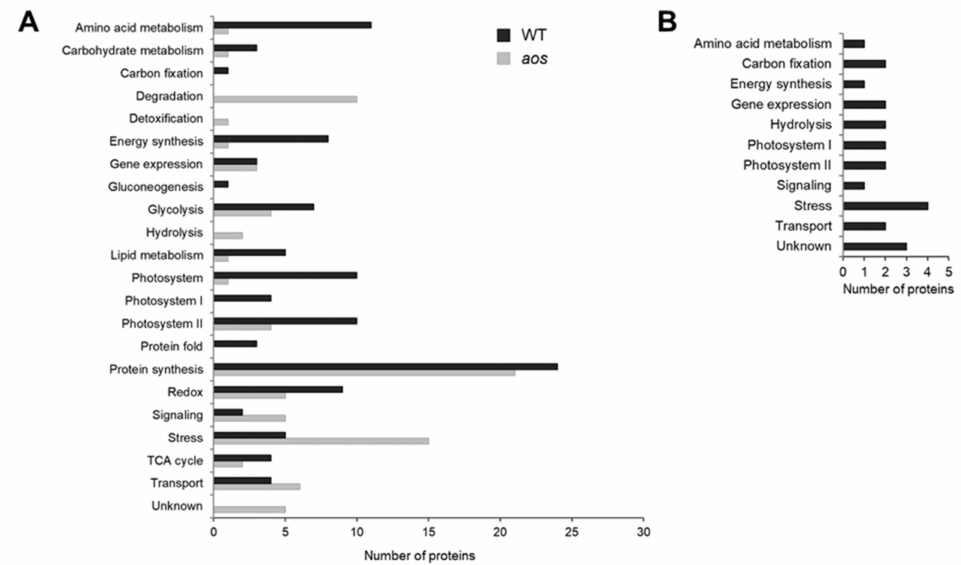
Figure 3. Functional categorization of proteins identified in response to wounding stress in P. patens wild-type and the aos mutant. ( A ) Functional categorization of proteins that accumulated in response to wounding in P. patens wild-type and the aos mutant. ( B ) Functional categorization of proteins that decreased in response to wounding in the wild-type P. patens . Three-week-old P. patens tissues were wounded using tweezers. After 24 h, proteins were extracted from the tissue and analyzed using a gel-free / label-free proteomic technique, and significantly changed proteins ( p < 0.05, matched peptides > 2) were identified using a student’s t -test. The identified proteins were annotated using Phytozome ver. 11.0.9 (https: // phytozome.jgi.doe.gov / pz / portal.html) and functionally